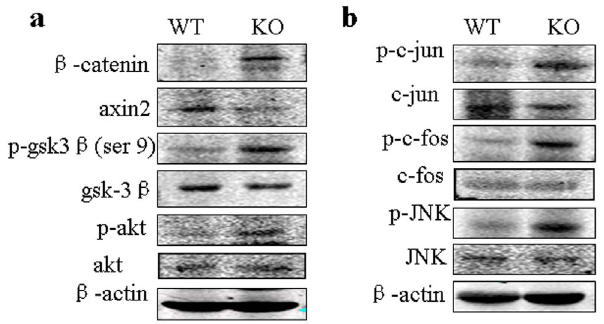
Figure 7. Gpr48 deficiency altered the expression of Wnt signal inhibitors and the activity of noncanical Wnt signal pathway. ( a ) Western blot analysis shows that p-akt and p-GSK3 b were increased while axin2 was decreased in gpr48 KO mice. ( b ) Western blot analysis depicts the levels of p-JNK, p-c-jun and p-c-fos in the kidneys of Gpr48 KO and WT adult mice.